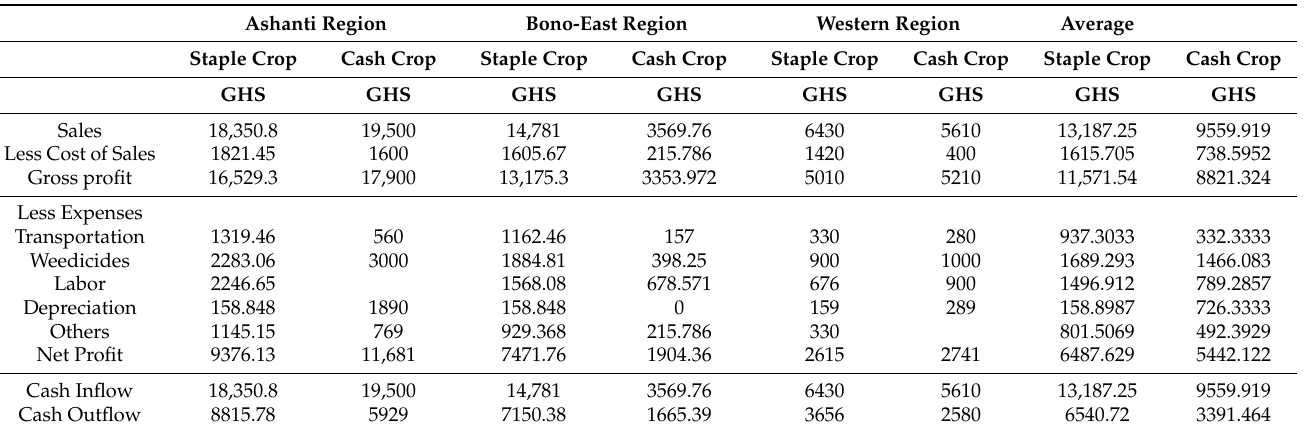
Table 3. Profit and loss statement for agricultural investors in the Ashanti, Bono-East, and Western Regions of